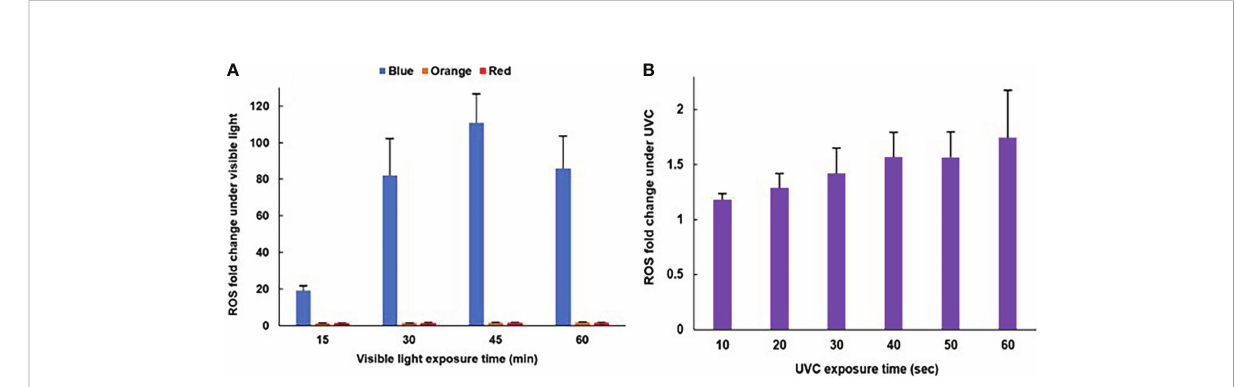
FIGURE 2 Time course of ROS generation after light exposures. (A) BL, OL, RL exposures ( N =5, mean ± standard deviation) (see Figure S1 for a scale enlarged bar plot for OL and RL). (B) UVC exposure ( N =5, mean ± standard deviation). For (B) , no statistical signi fi cance was